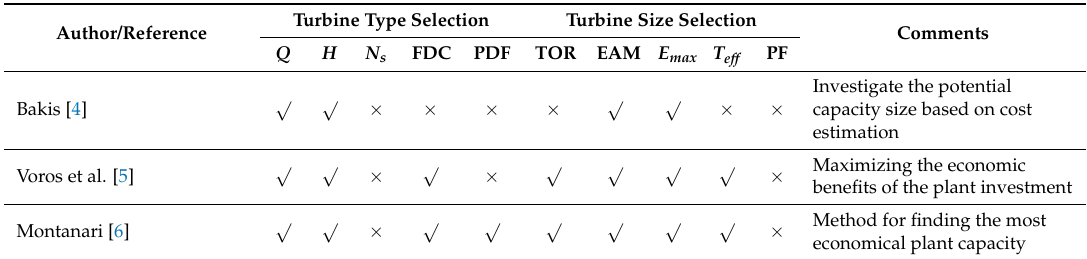
Table 1. Research summary of hydropower plant turbine size and type